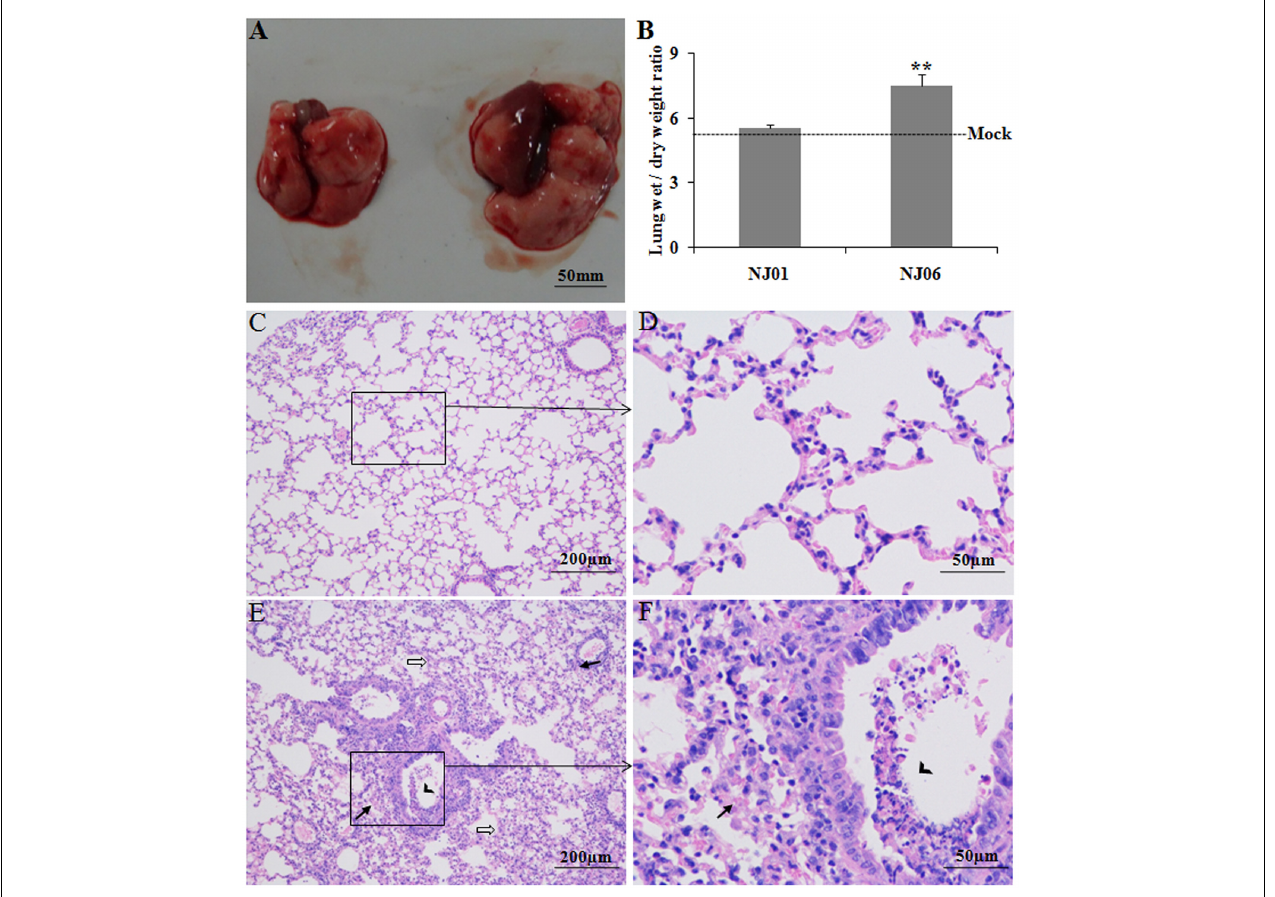
FIGURE 3 | Lung lesions in mice. Groups of BALB/c mice were intranasally inoculated with 10 5 EID 50 of the NJ06 and NJ01 viruses, respectively, gross pathology, water content, and histopathology of lungs were determined at 5 days post inoculation (dpi). (A) Gross pathology of H9N2virus-infected lung. Severe edema, congestion, and hemorrhage were observed in NJ06-infected lung (left), and the NJ01-infected lung (right) appeared normal except for occasional small dark red foci. (B) Lung wet/dry weight ratios of H9N2 virus-infected mice. Data represent the means of the results determined for three independent experiments ± standard deviations. ∗∗ indicates p < 0.01 compared with the mock group. (C,D) Representative histopathological changes in NJ01-infected lungs (H&E-stained). Only mild and limited alveolitis was observed. (E,F) Representative histopathological changes in NJ06-infected lungs. Solid arrows indicate inflammatory cell infiltrates around the bronchus, open arrows indicate edema and thickening of alveolar walls, Solid arrowheads indicate desquamation of epithelial cells in bronchial